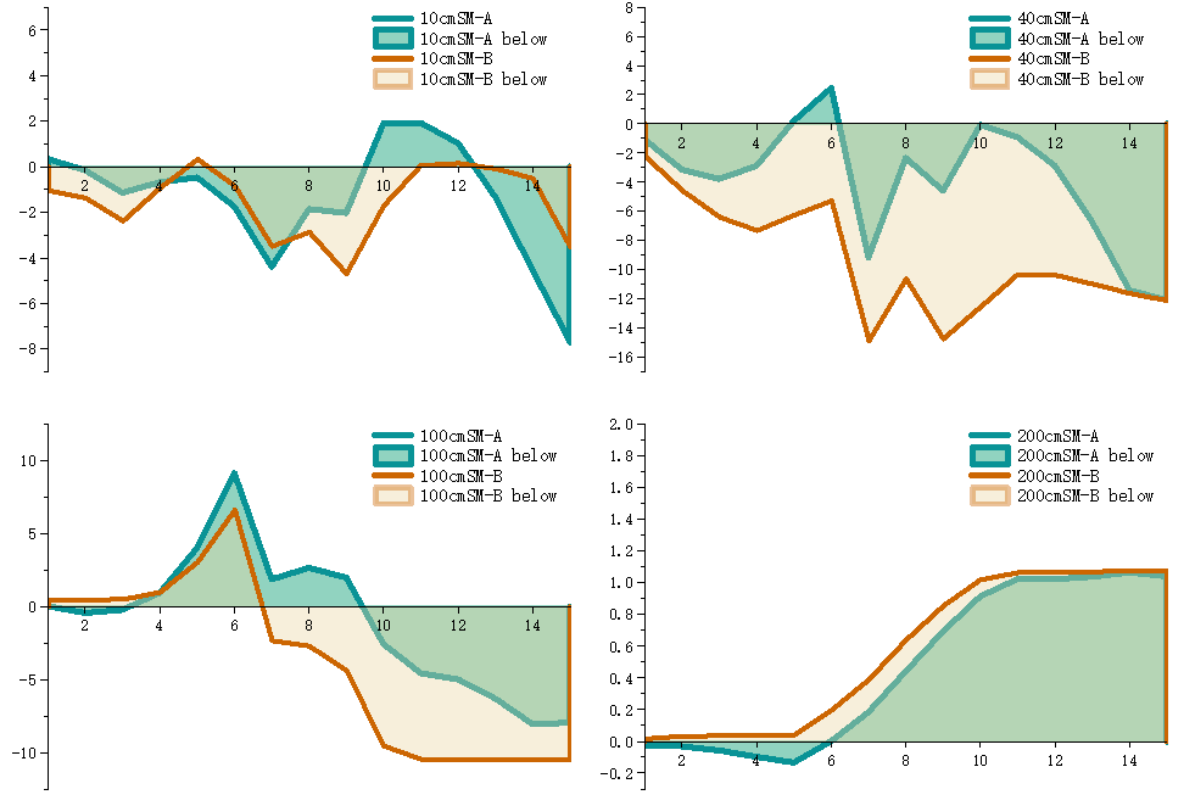
Figure 8. Predicted residual area charts of different models at different depths.